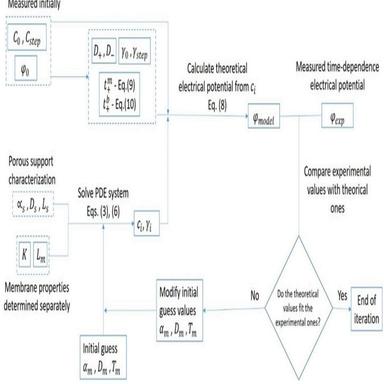
Modelling procedure diagram to obtain model parameters m m m , , D T from the experimental data.